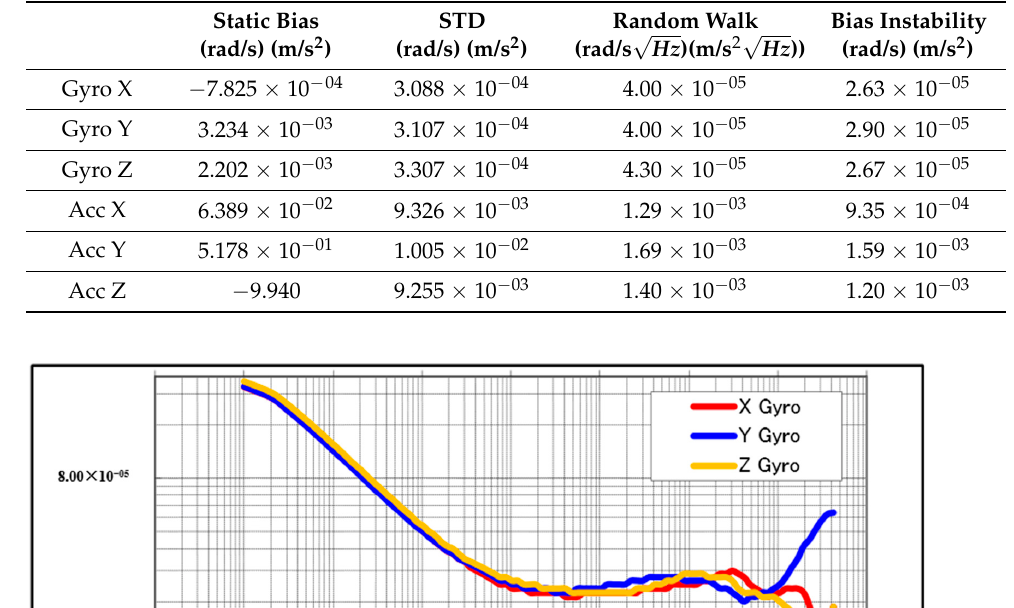
Table 1. Parameter estimation by Allan variance (AV).